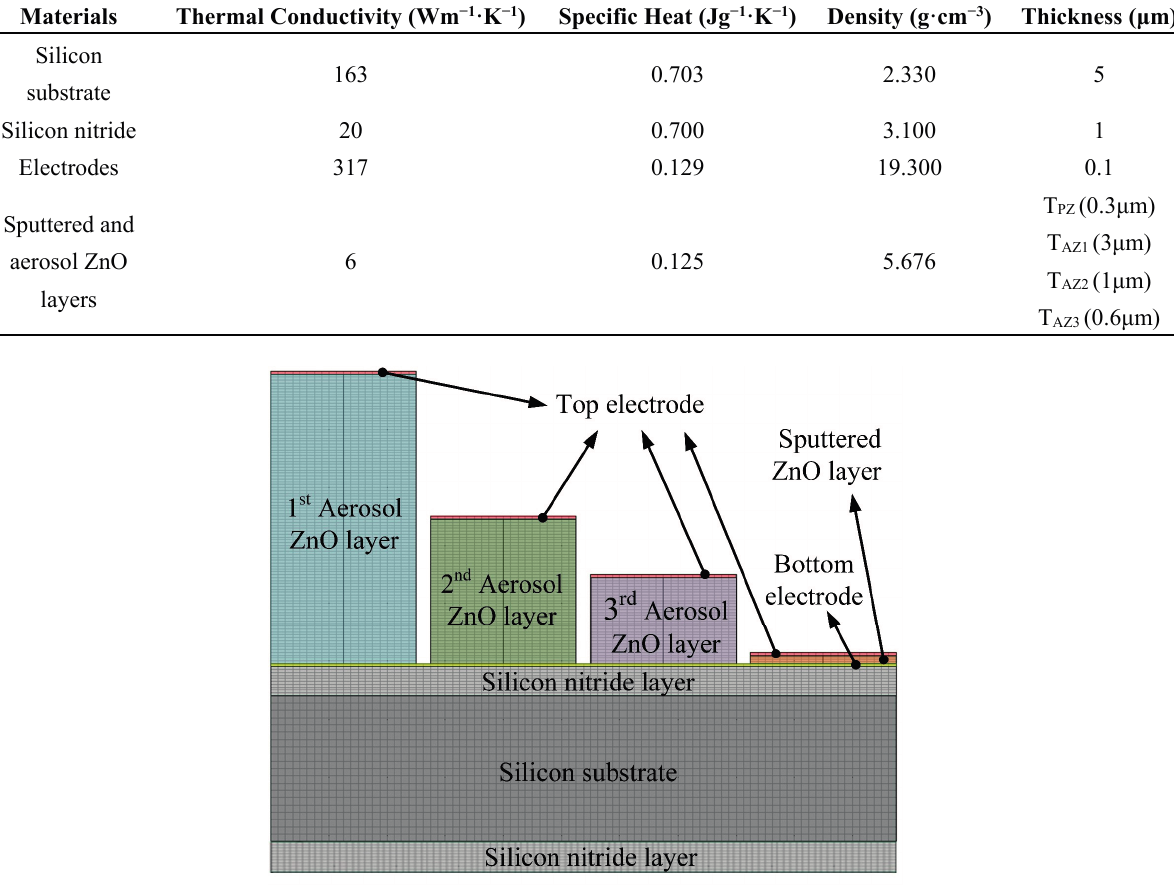
Figure 2. Two-dimensional numerical model for the multi-frequency band ZnO pyroelectric